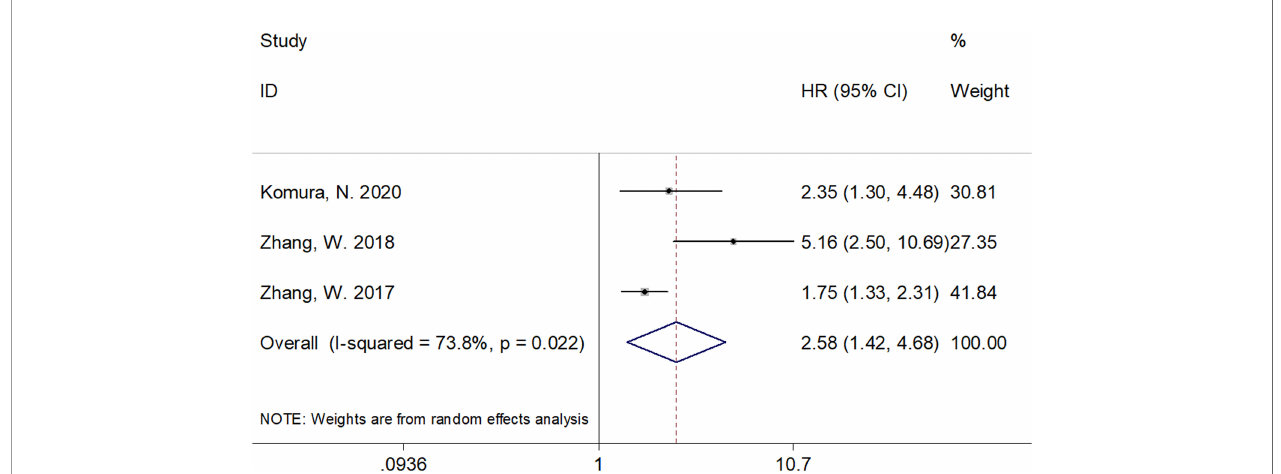
FIGURE 3 | Forest plots of studies evaluating the hazard ratio for progression-free survival (PFS)/disease-free survival (DFS) of patients with gynecological cancers of a high CRP/Alb ratio.